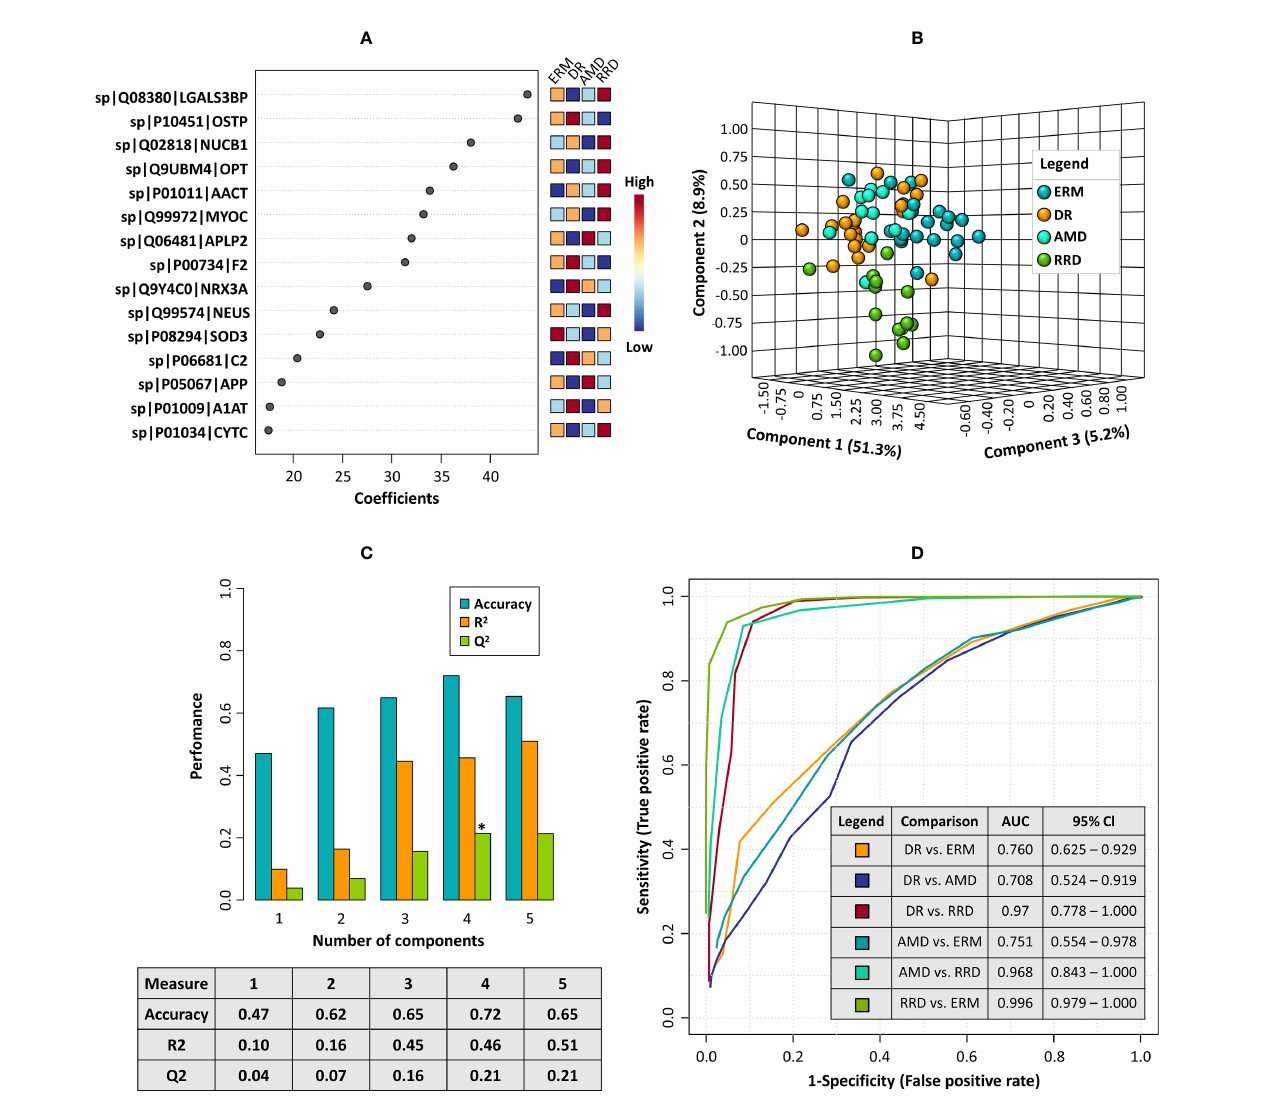
FIGURE 6 (A) The plot of the top fi fteen candidate biomarkers according to the partial least squares discriminant analysis (PLS-DA) model. (B) 3D principal component analysis (PCA) plot shows the separation between disease groups based on the top fi fteen candidate biomarkers panel (C) Barplot representing the values of predictive ability (Q2), R-Squared (R2), and accuracy calculated for the PLS-DA model in the cross-validation analysis. (D) Combined ROC curves showing the results of multivariate receiver operating characteristics for the panel of 15 candidate biomarkers, including the area under the curve (AUC) and the con fi dence intervals (95% Cl) for each comparison between different disease